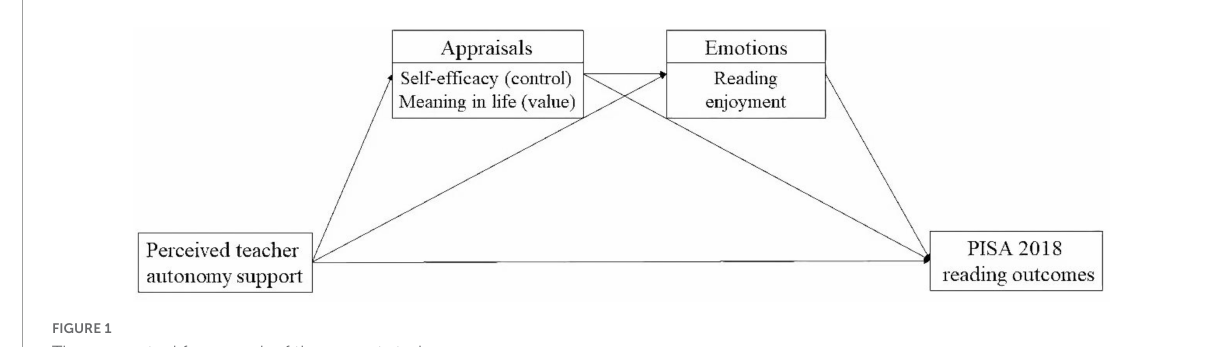
FIGURE1 The conceptual framework of the current